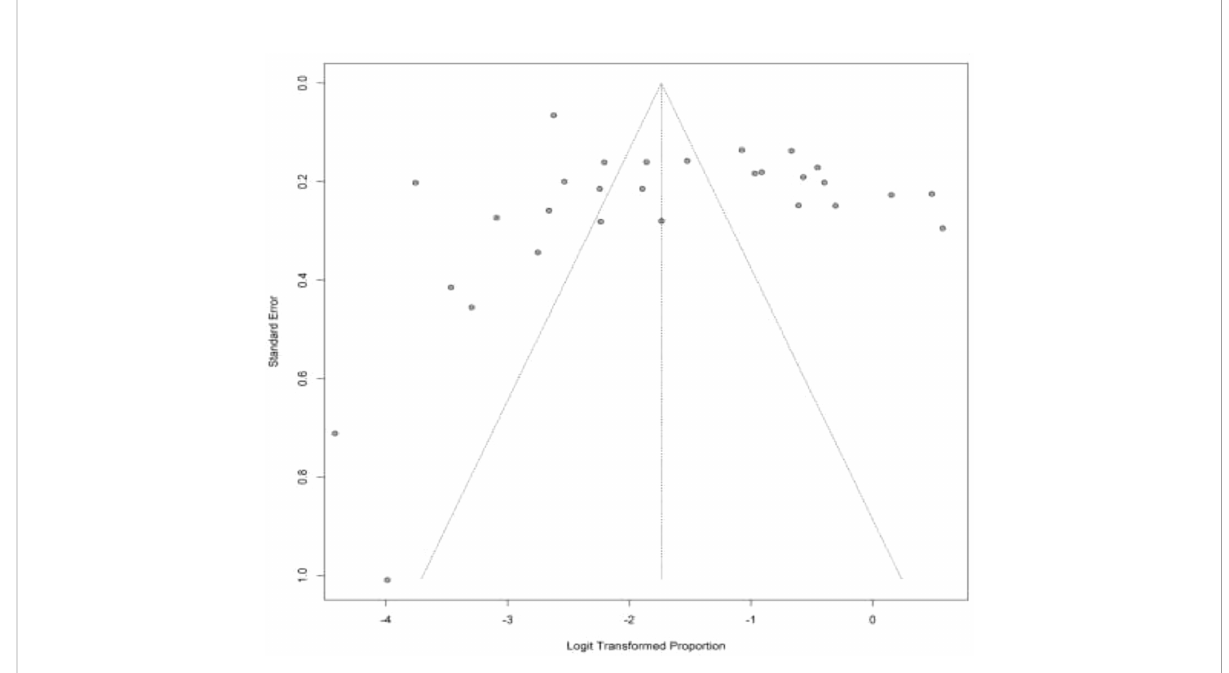
FIGURE 3 Funnel plot of enrolled studies based on abnormal